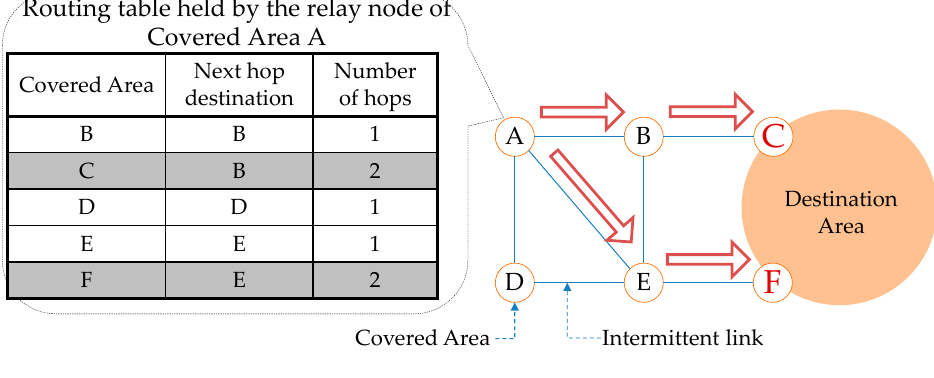
Figure 6. Layout example of the destination area and covered areas.